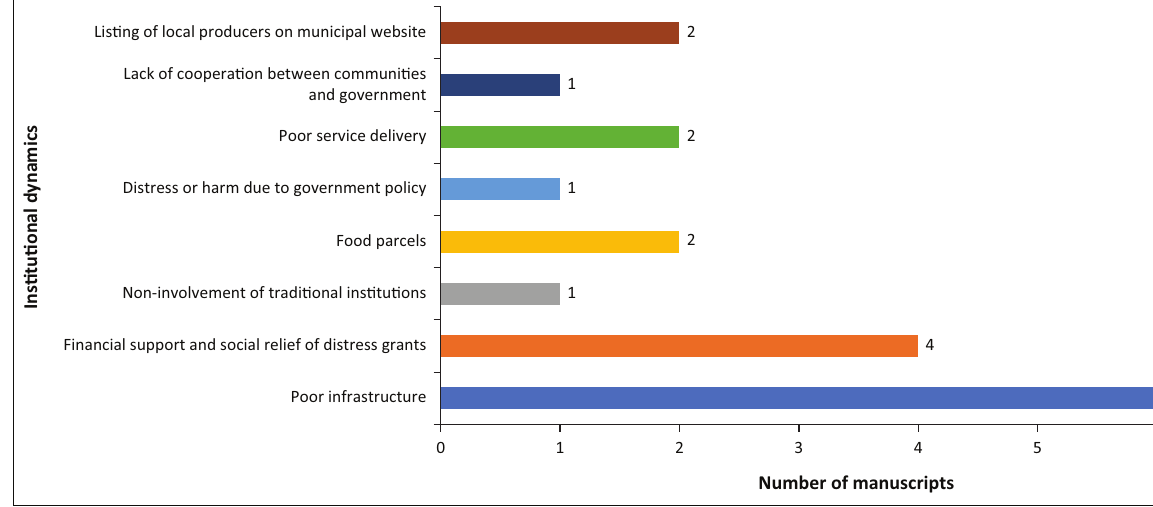
FIGURE 7: Coping strategies during the pandemic.